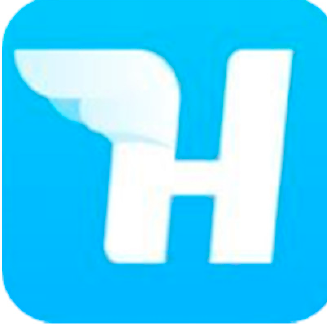
Figure 2. Logo of the SM app.